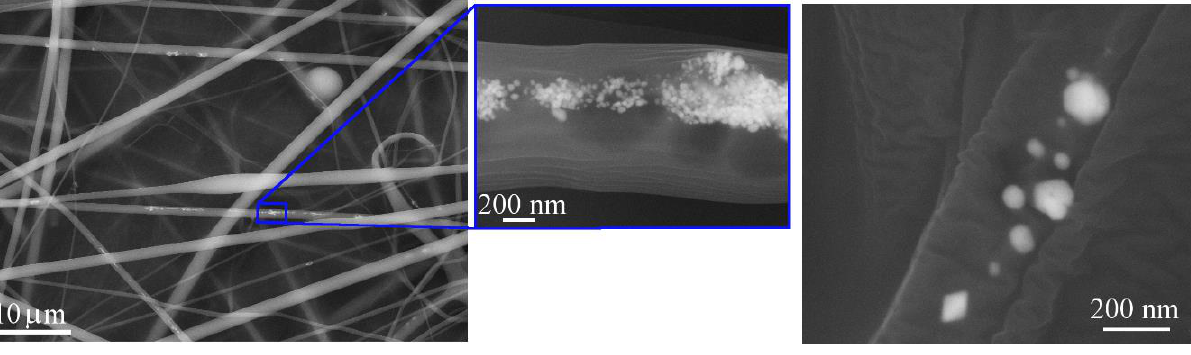
Figure 5. SEM images of in situ PVA-5AgNPs fibers with detailed view of the AgNPs shape and distribution.